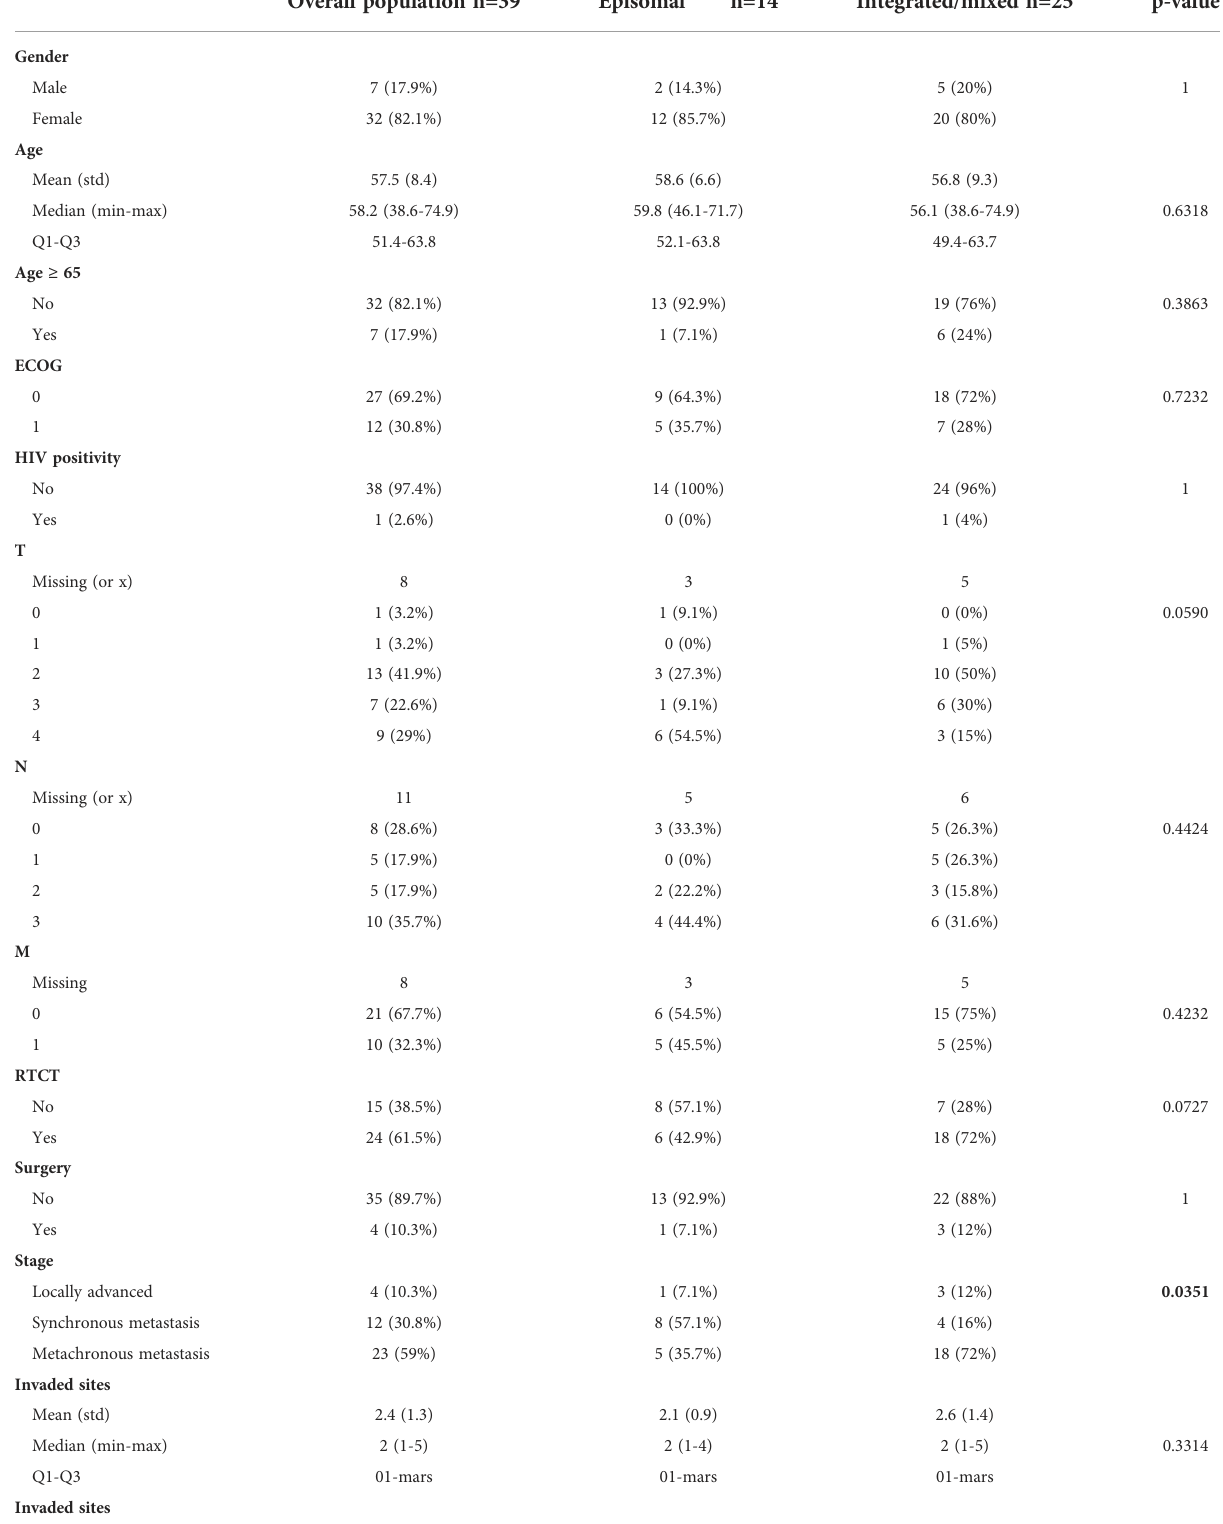
TABLE 6 Clinical characteristics of SCCA patients according to HPV genome